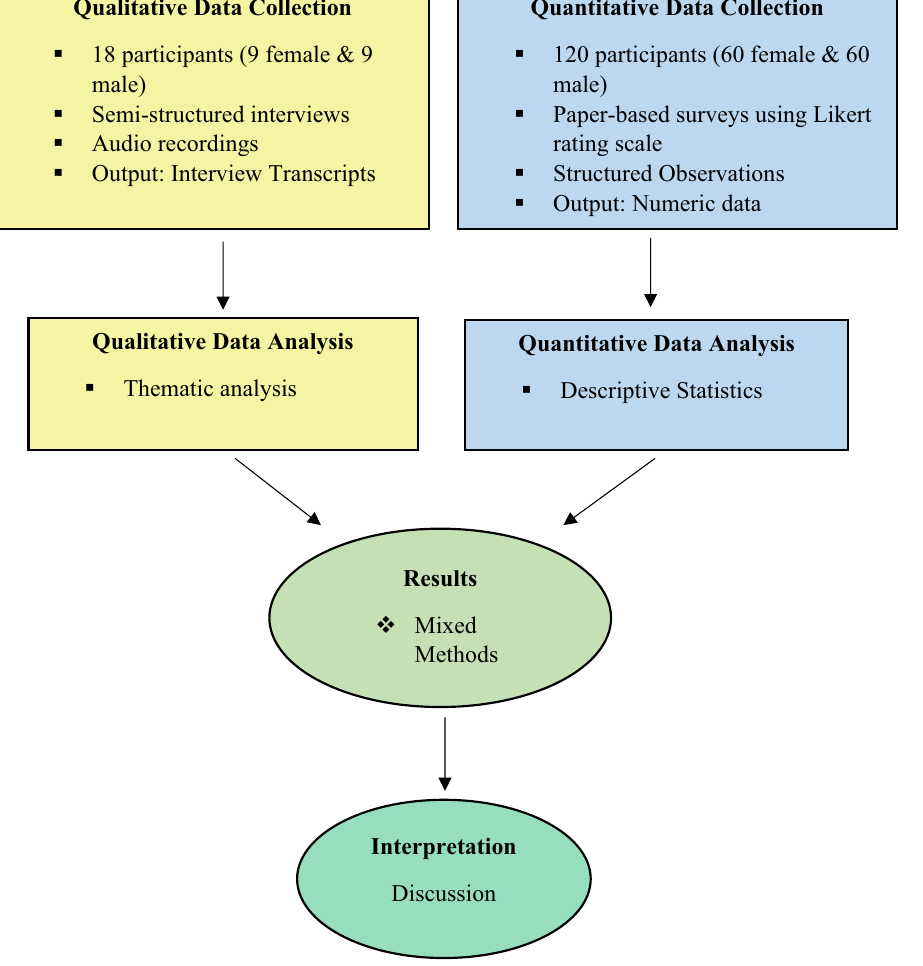
Figure 1. Diagram of concurrent mixed methods design (Forman